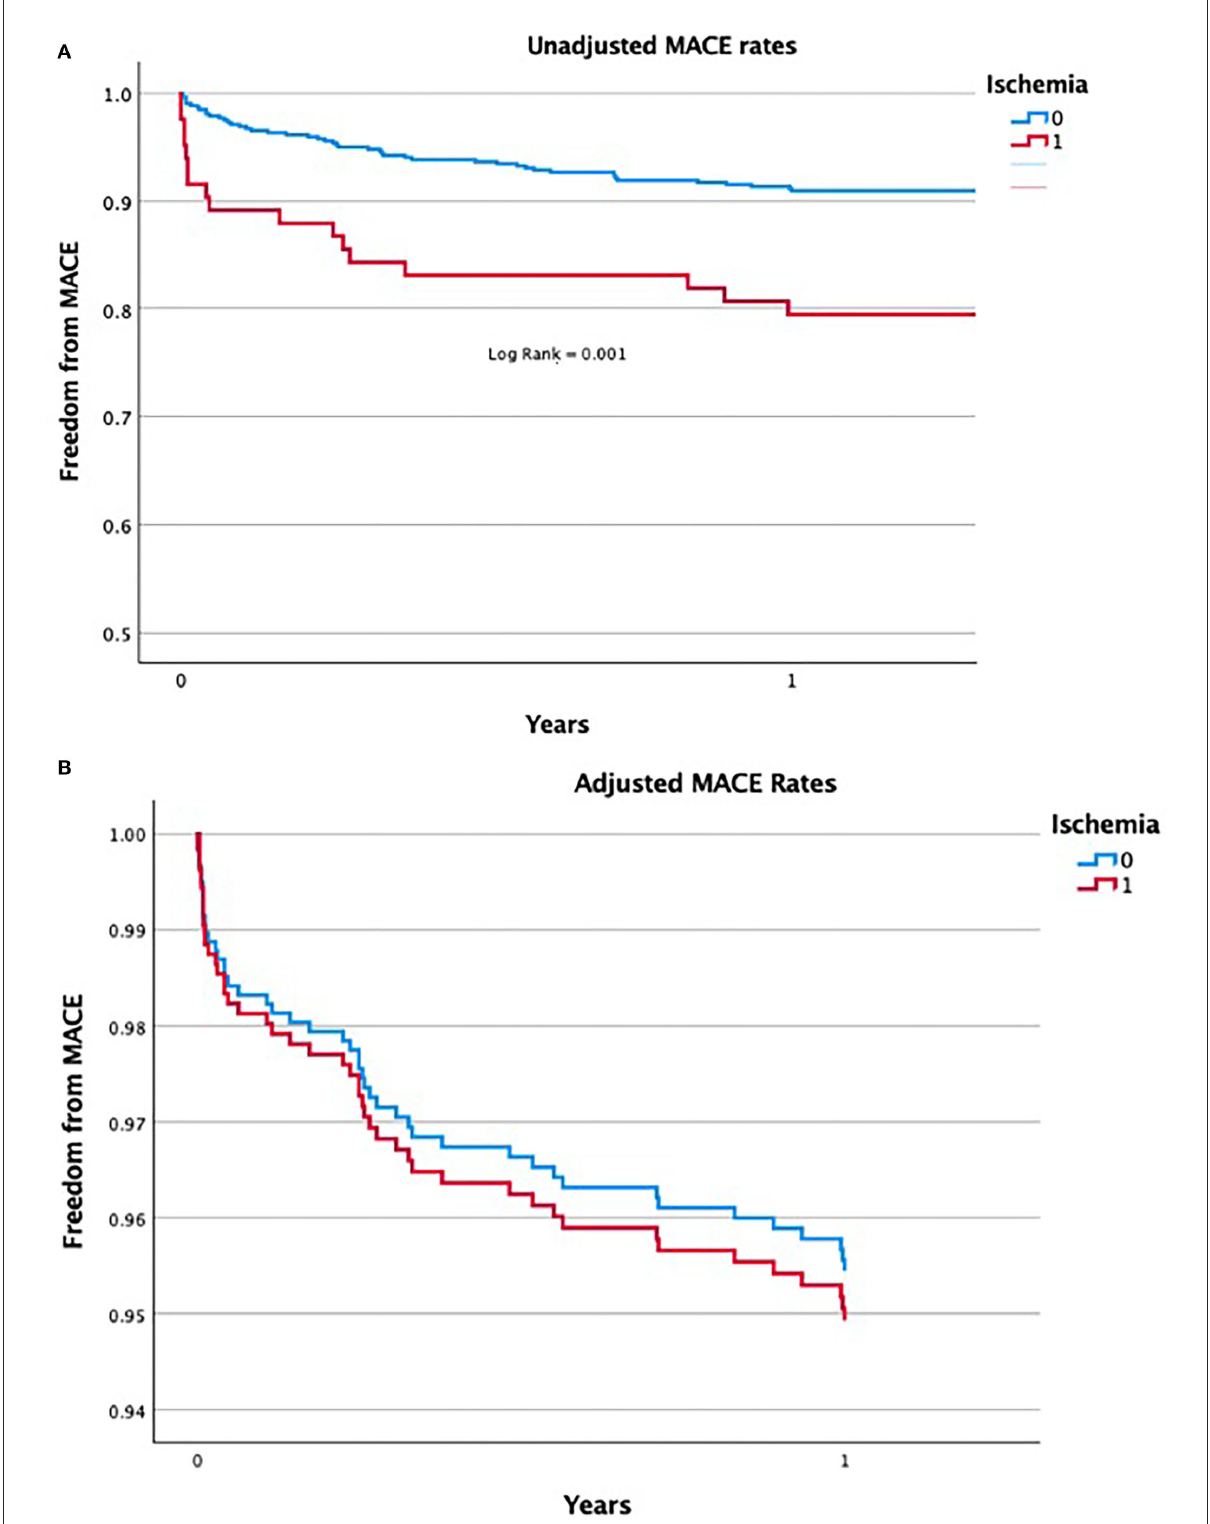
FIGURE1 (A) Unadjusted rates of MACE in patients with abnormal SPECT test results compared to patients with normal SPECT scan. (B) Adjusted rates of MACE in patients with abnormal SPECT test results compared to patients with normal SPECT